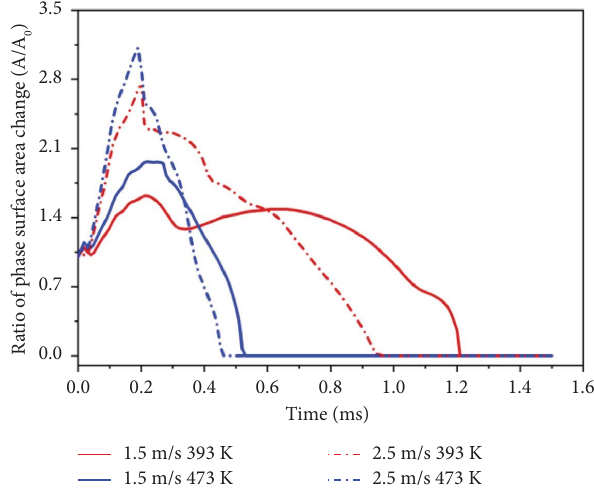
Figure 10: Ratio of the phase surface area change during droplet collision